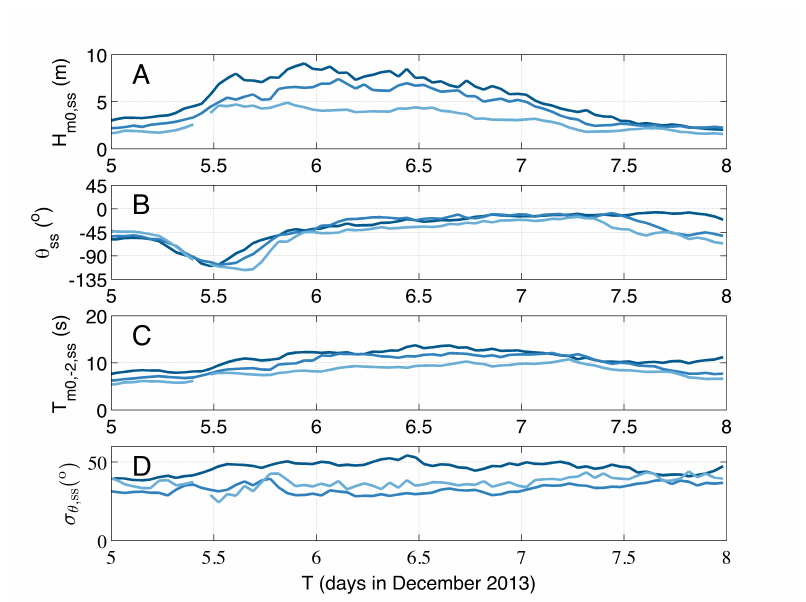
Figure 3. Sea-swell conditions during storm Xaver at locations A12 (dark blue), Q1 (blue) and EUR (light blue). ( A ) Significant Wave height H m 0, ss . ( B ) Mean wave direction θ ss (Nautical convention). ( C ) Wave period T m 0, − 2, ss . ( D ) Mean directional spreading σ θ , ss . Computing the bound IG wave height with Equation (8) based on the hourly frequency-